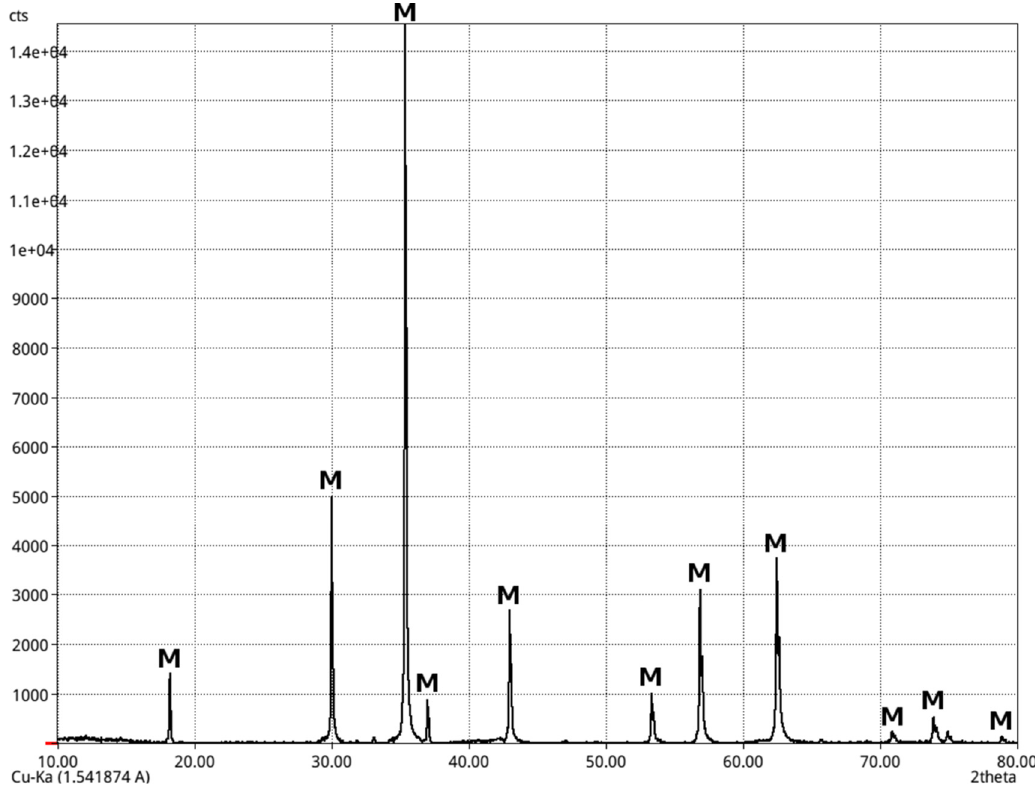
Figure 6. XRD pattern of as-received oxy-cutting fines (M = magnetite).